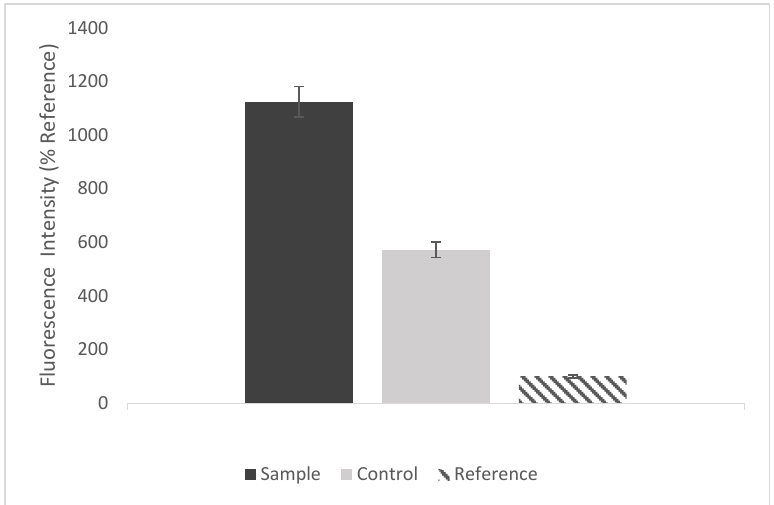
Figure 8. The fluorescence intensity as % of Reference .